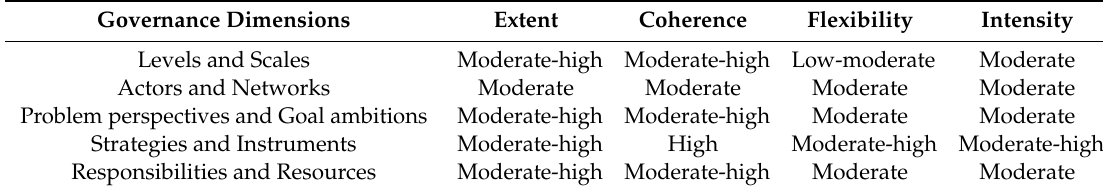
Table 4. Results of the governance